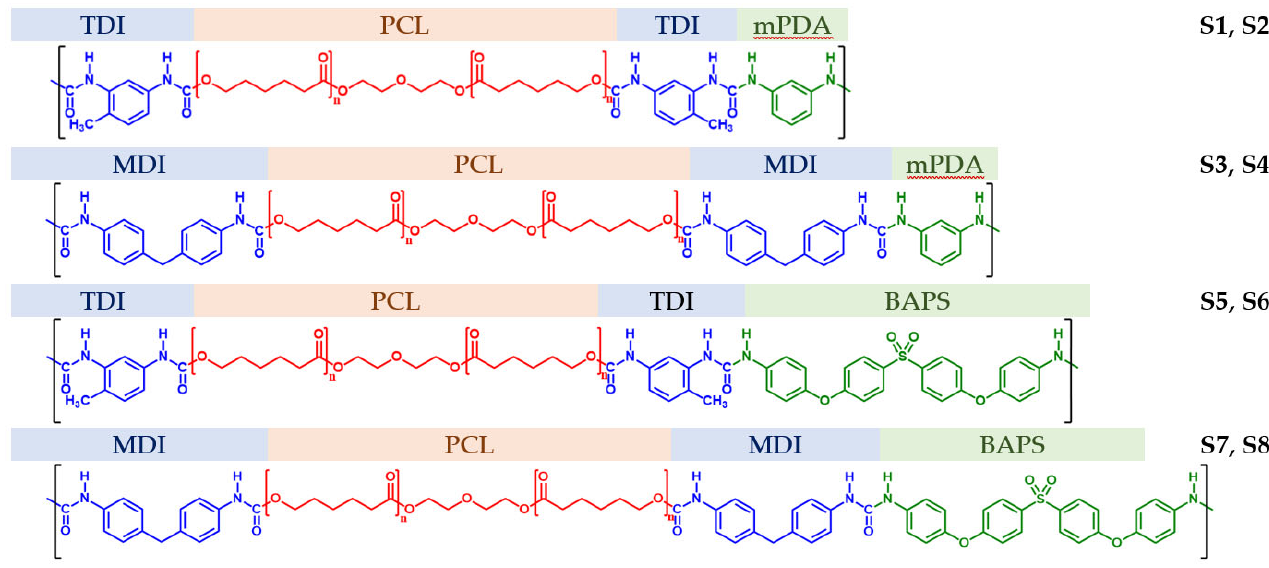
Figure 1. Chemical formulas of segmented PUU synthesized during step ‐ growth polymerization according to the two ‐ step scheme: S1 ‐ S8. PCL molecular masses for S1, S3, S5, S7 are 530, and 2000 g ∙ mol ⁻ ¹ for S2, S4, S6, S8.